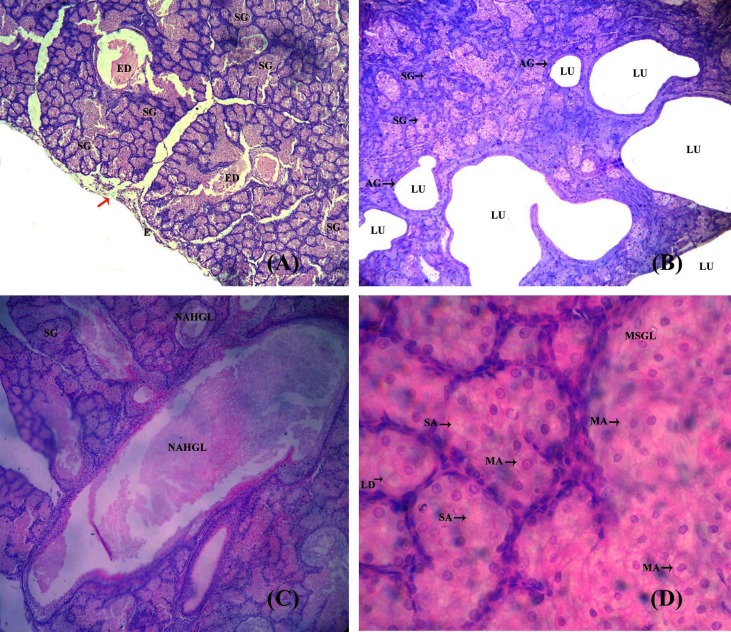
(A-D): Histological structure of preputial gland of Millardia meltada: ED-Excretory duct; E-Epidermis; SG-Sebaceous gland; Red arrow-the branched large sebaceous glandular lobules directly open into the skin surface; AG-Apocrine gland is a simple tubular gland and the secretion are found in the lumen (LU); NAHGL-Normal alveolar holocrine glandular lobules; MSGL-Modified sebaceous glandular lobules; SA-Serous acini; MA-Mucus acini; LD-Lipid droplets.